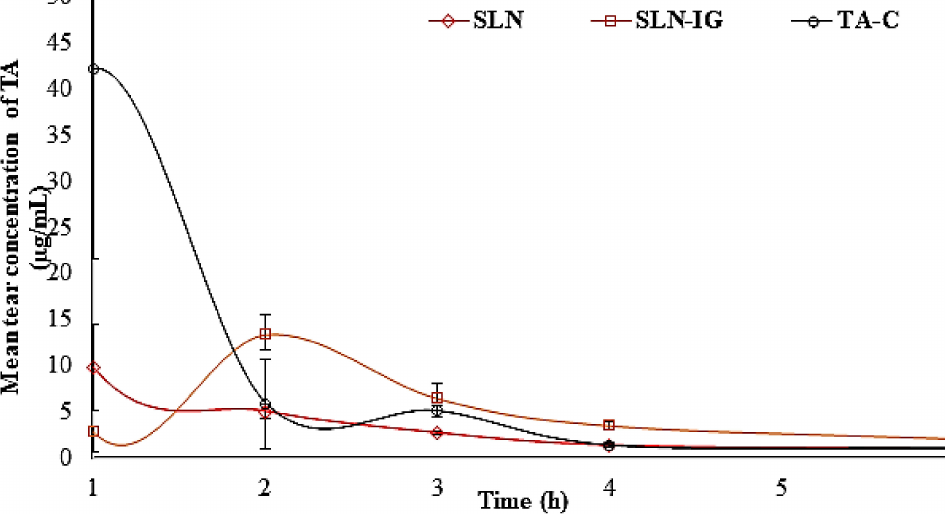
Figure 5. Mean tear concentration-time profiles of triamcinolone acetonide after topical administration of TA-SLN (F5), TA-SLN-IG (F13), and TA-C in New Zealand albino rabbits (mean ± SD, n =